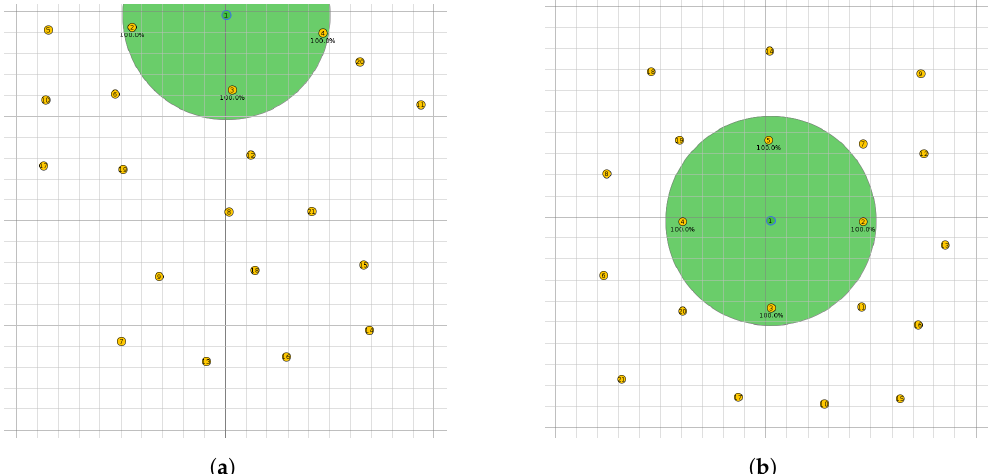
Figure 8. Possible placements of nodes. The green area represents the transmission and interference ranges, both equal to 50m. The size of the grid is 200m × 200m. ( a ) Placement 1: the sink node is situated at the top of the grid. ( b ) Placement 2: the sink node is situated in the middle of the grid.